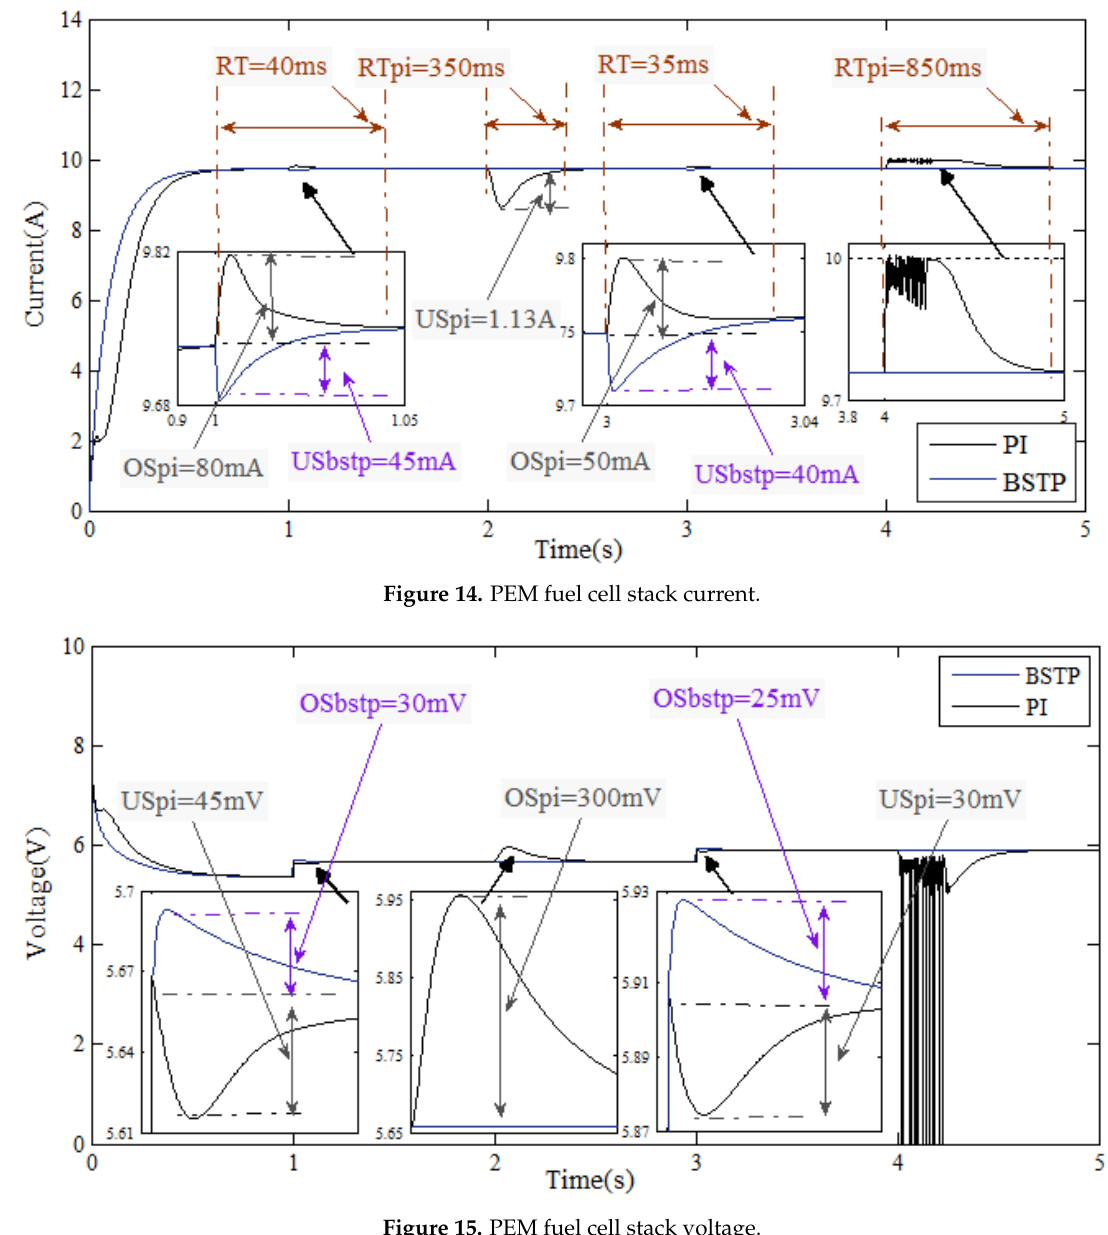
Figure 15. PEM fuel cell stack